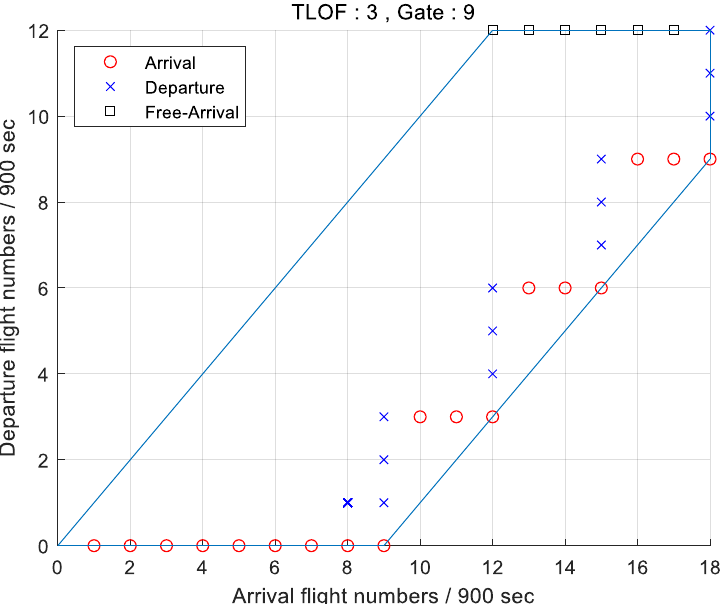
Figure 34. Capacity of a satellite topology for Gimpo Airport’s expanded parking lot space that complies with the FAA’s new regulations.